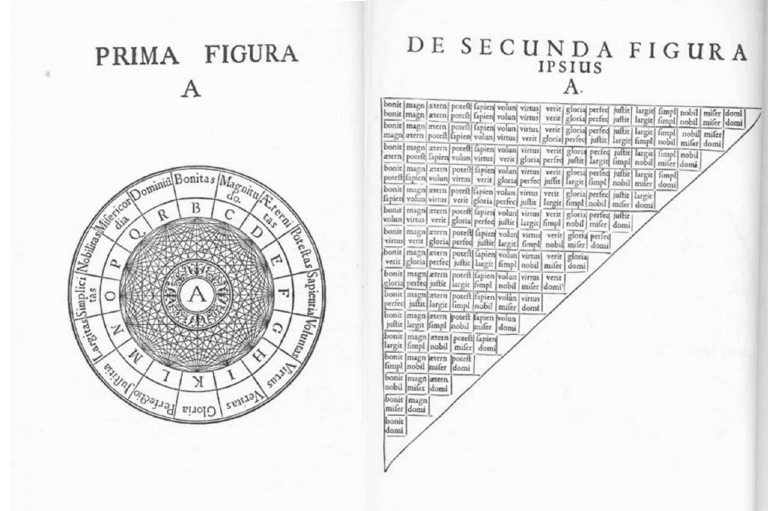
Figure 10. Figure A from the Ars demonstrativa, representing God and his dignities. Source: Mainz Latin edition (MOG), 1722, Vol. III 21 . The second figure shows all binary